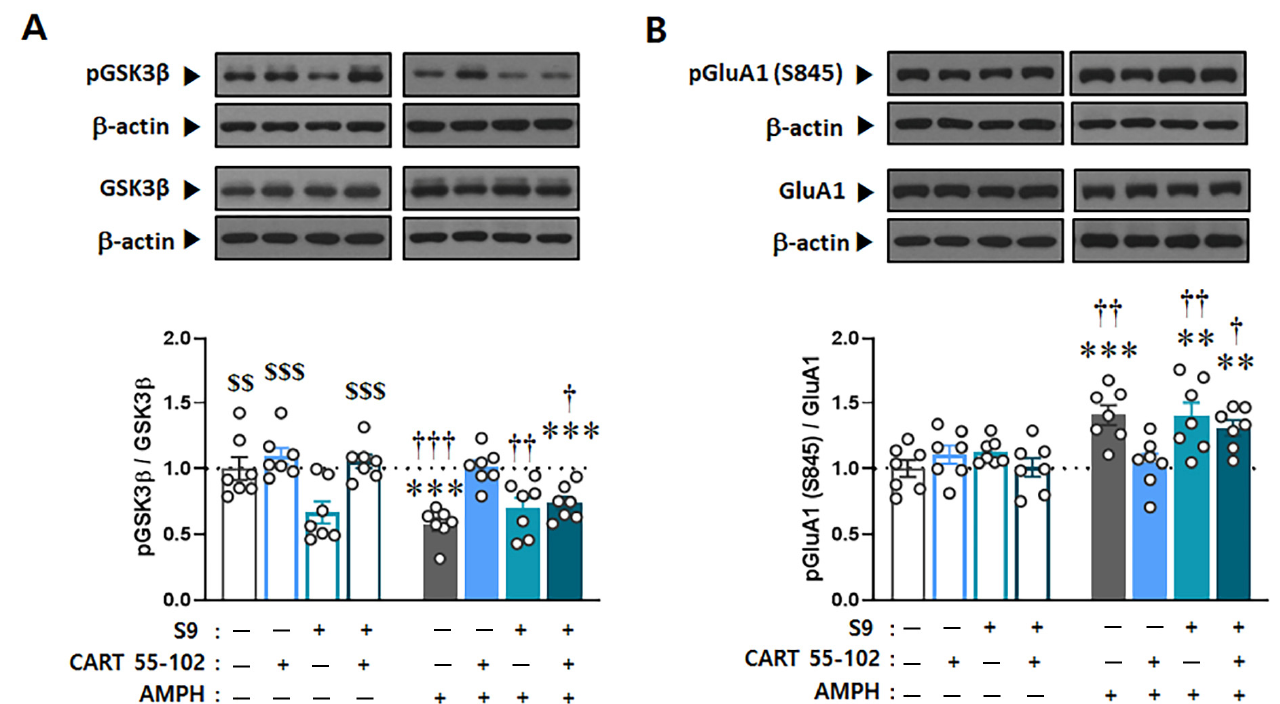
Figure 5. Interruption of Akt-GSK3 β signaling in the NAcc core abolishes inhibitory effects of CART peptide 55–102 on AMPH-induced phosphorylation changes of GSK3 β and GluA1. Representative Western blots of total and phosphorylated forms of GSK3 β ( A ) and GluA1 ( B ) are shown. Values for the band intensities were first normalized to β -actin, and the average values for the ratio of phos- phorylated to total proteins in each group are expressed as mean (+S.E.M.) relative to saline—saline microinjections + saline IP injection group. Symbols indicate significant differences as revealed by post hoc Tukey comparisons following two-way ANOVA. $$ p < 0.01, $$$ p < 0.001, significant differ- ences compared to S9–saline microinjections + saline IP injection. ** p < 0.01, *** p < 0.001,